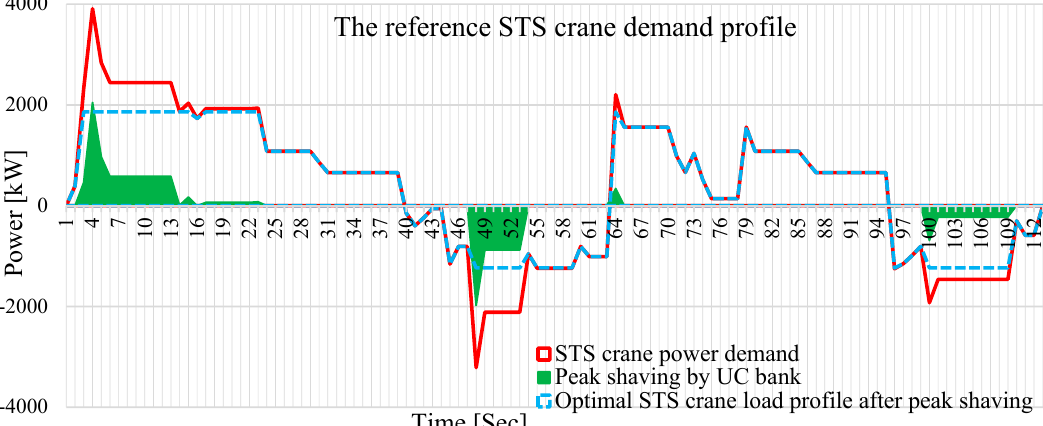
12 of 19 Table 4. Percentage of the peak shaving based on UC bank for the STS crane. Total RE [kWcycle]